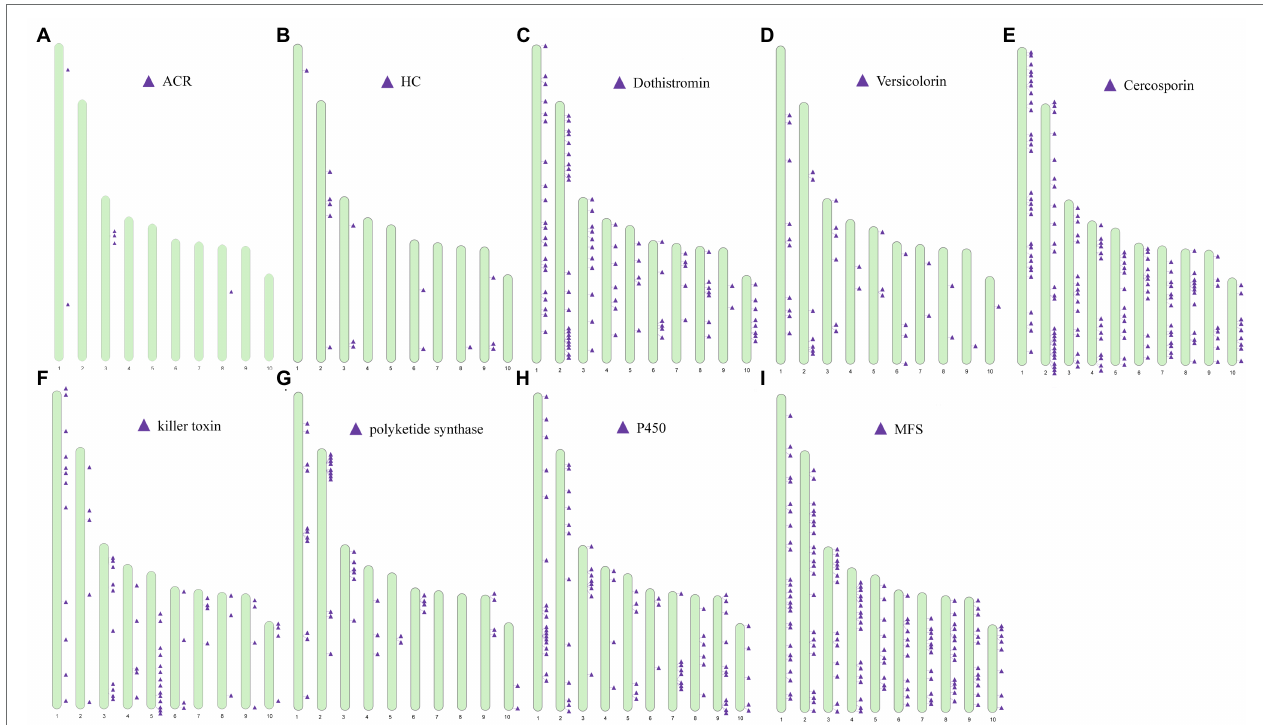
FIGURE 9 | Distribution and location of toxin gene and regulator [P450s and major facilitator superfamily (MFS)] clusters on the ten chromosomes identified in A. alternata (Y784-BC03). (A–I) represent predicted toxins (ACR, HC, Dothistromin, Versicolorin, Cercosporin, killer toxin) and regulators (polyketide synthase, P450 and MFS), respectively.